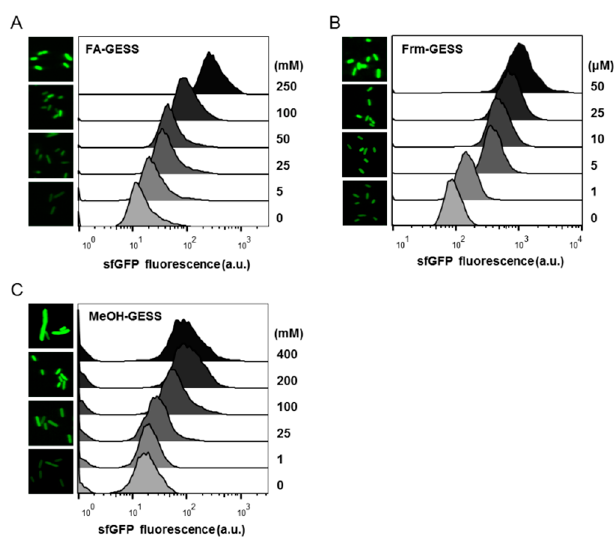
Figure 3. Flow cytometric analysis and microscopy images of the C1 biosensors. ( A ) Formate biosensor. ( B ) Formaldehyde biosensor. ( C ) Methanol biosensor. Fluorescence-activated cell sorting